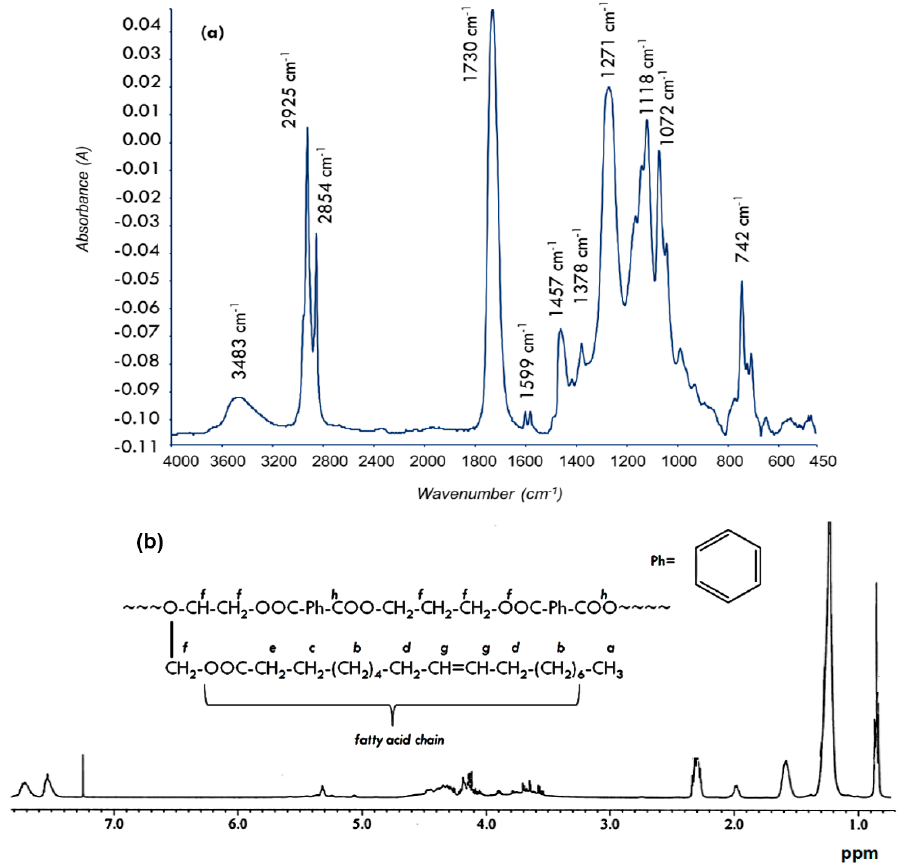
Figure 2. Spectroscopic characterizations of core material (alkyd AlkPKO65): ( a ) FTIR spectrum; and ( b ) 1 H-NMR spectrum. Table 2. Properties of alkyd AlkPKO65.